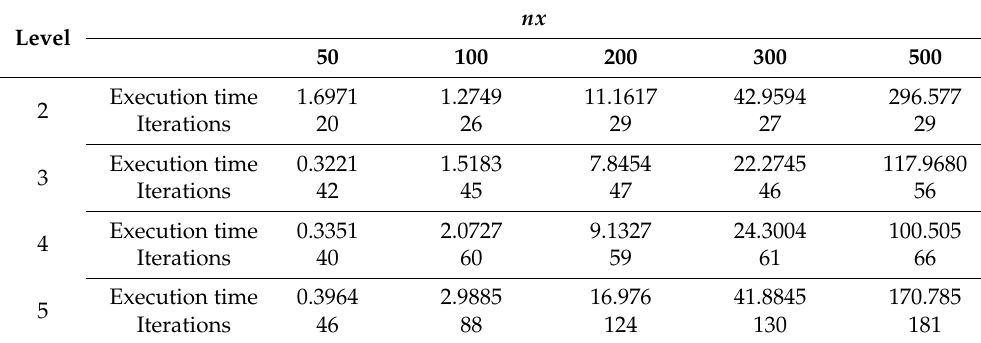
Table 2. Convergence behavior and performance of V cycle of AGAMG in combination with deflation technique for 2D Poisson model